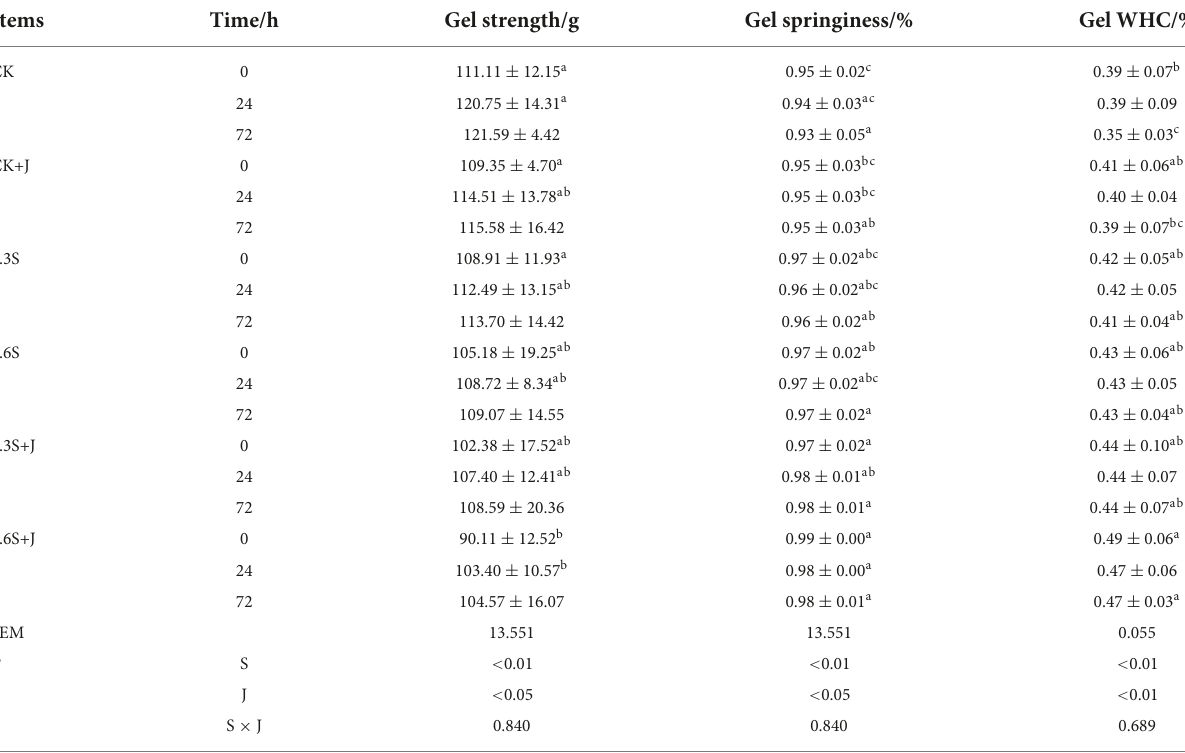
TABLE 6 Changes on gel properties of post-mortem chicken myofibrillar protein from selenium yeast and jujube powder dietary supplements.